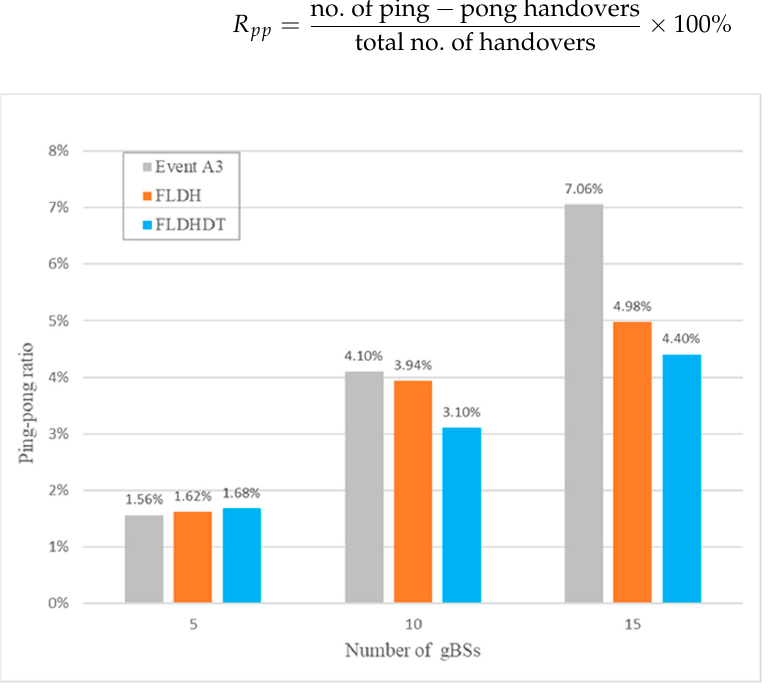
Figure 12. Ping-pong ratio versus number of gNBs.